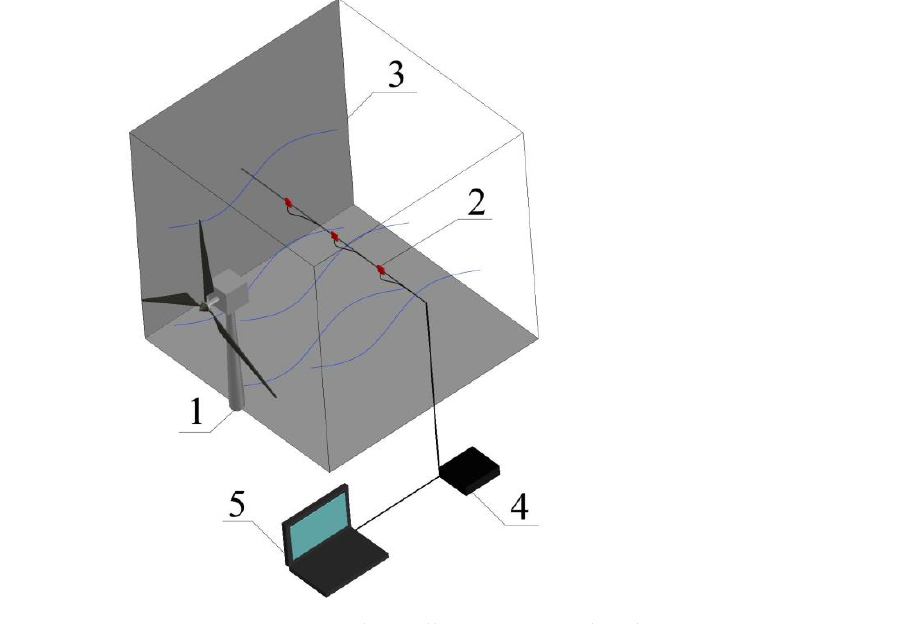
Figure 1. Experimental installation: 1—wind turbine, 2—tape sensors, 3—measuring channel, 4—controller, 5—laptop. 4—controller,